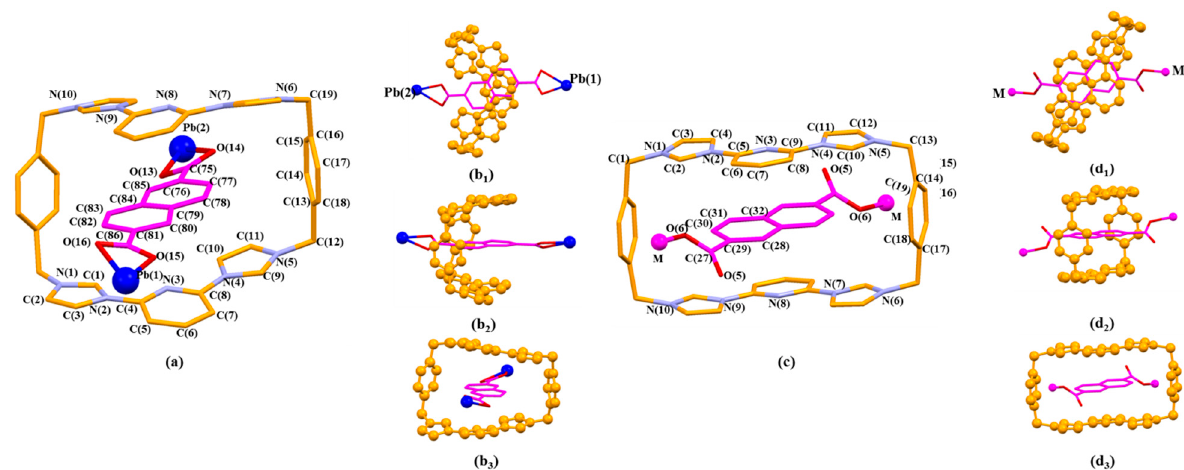
Figure 9. The pseudorotaxane unit [ 1 4+ • 3 • Pb 2 ] 6+ found in the single crystal X-ray structure of [ 1 4+ • ( 3 ) 5 • Pb 3 • 12.5H 2 O] (MORF-Pb-2). Shown in the stick form with atom-labelling scheme ( a ). Top ( b 1 ), side ( b 2 ), and front ( b 3 ) views of